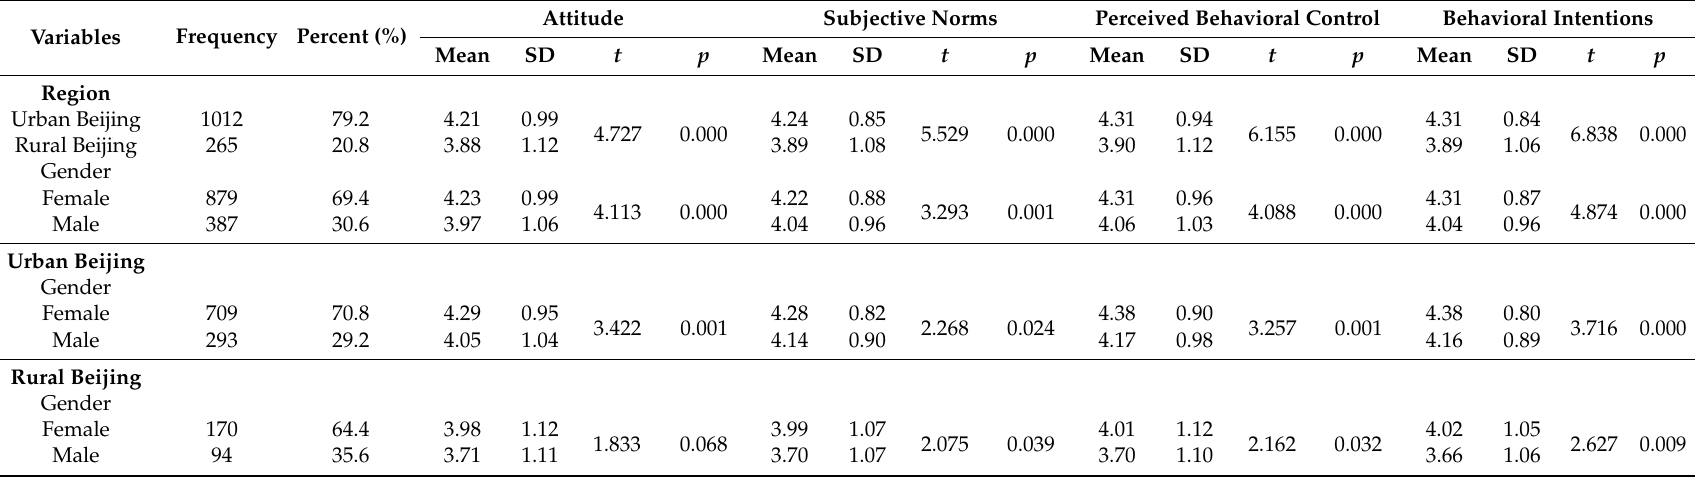
Table 1. Descriptive statistics and difference analyses related to demographic issues of attitude, subjective norms, perceived behavioral control, and behavioral intentions.